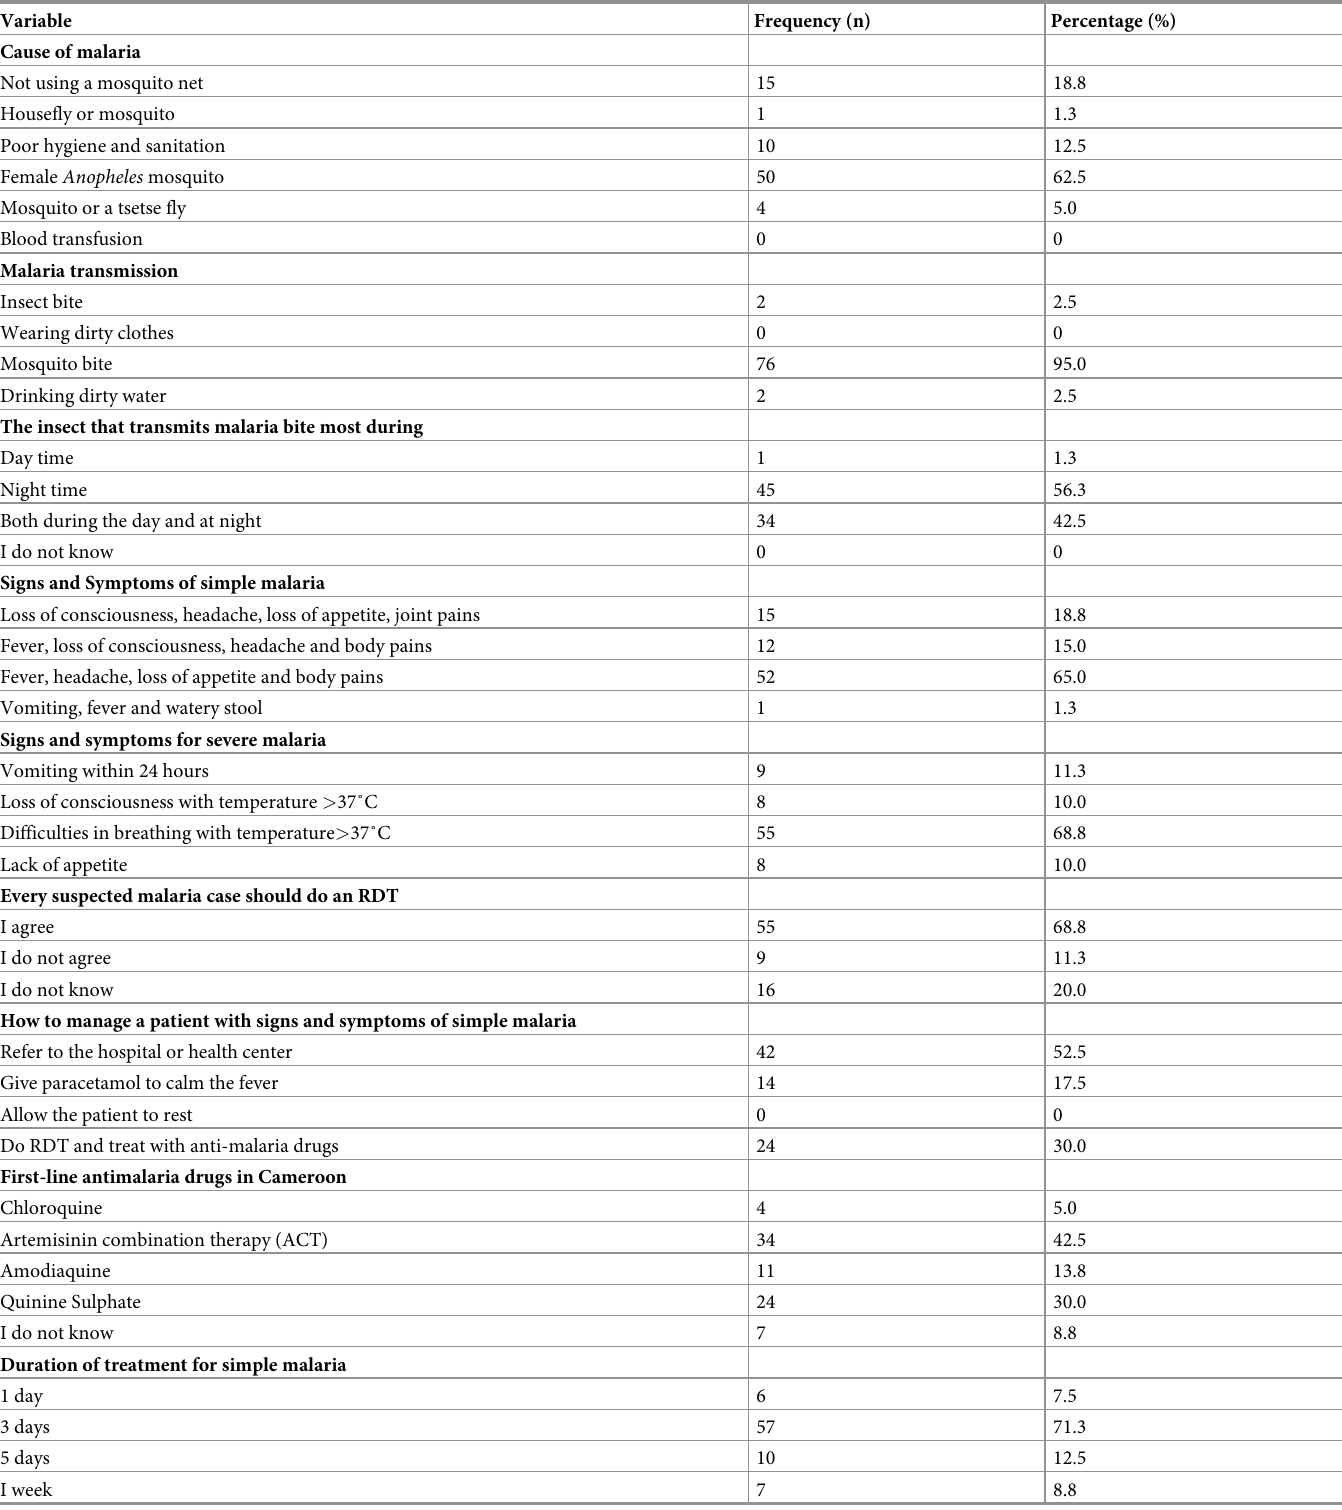
Table 3. CHWs’ Knowledge of management and prevention of childhood